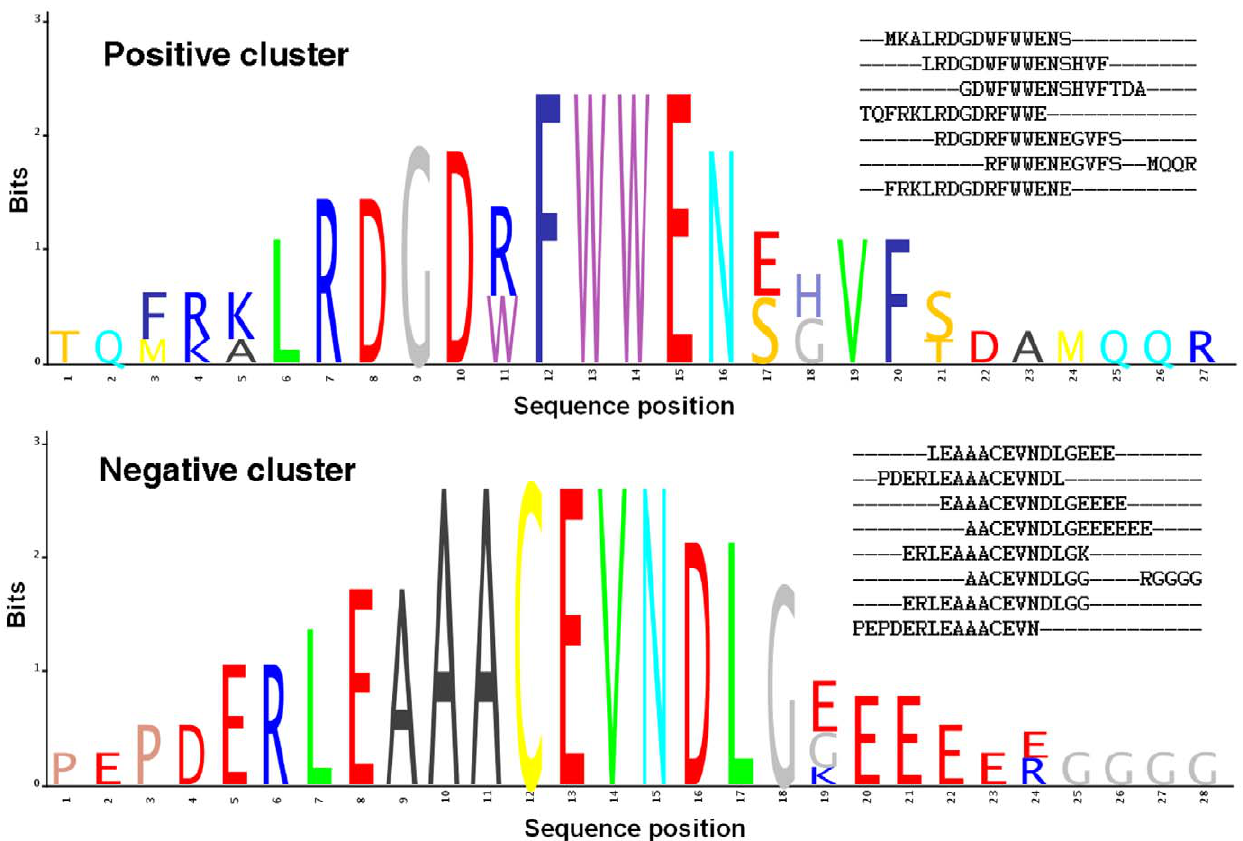
Figure 3. ROC curve and Precision-Recall curve of the two best final models. The figure displays the ROC curve (top) and the Precision- Recall curve (P-R) (below) calculated for the two best final models: logistic regressions fitted on the features contained in the subset B (model B) and in the subset C (model C).